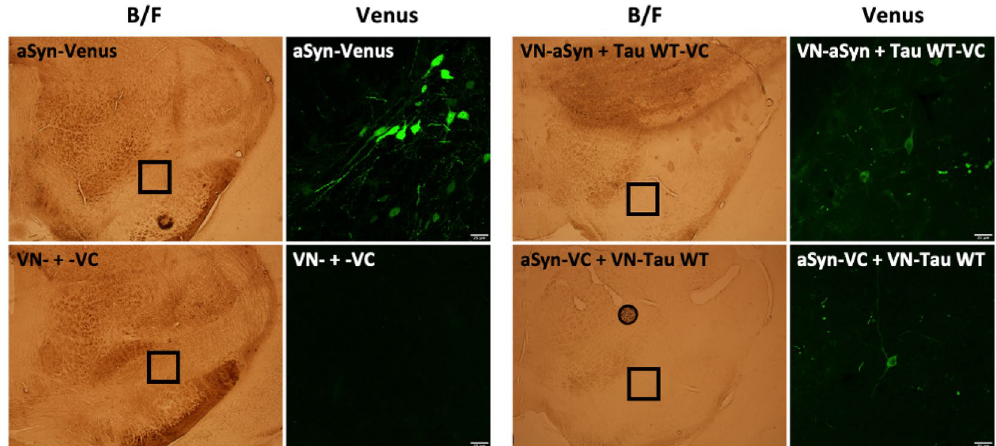
Figure 3. aSyn-Tau interaction in mouse substantia nigra pars compacta (SNpc). BiFC interaction in mouse SNpc. 10–12-week-old mice were injected in SNpc with AAV6 carrying different BiFC constructs. After 15 weeks, Venus fluorescence was evaluated. The expression of aSyn fused to full-length Venus provided the maximum level of fluorescence expected. The interaction of aSyn and Tau was reflected by Venus complementation in VN-aSyn + Tau WT-VC and VN-Tau WT + aSyn-VC injected animals. As expected, the expression of the Venus halves not linked to proteins did not produce any fluorescence in the injected area. Boxed area on Bright Field (B/F) images is magnified to the right. Scale bar: 25